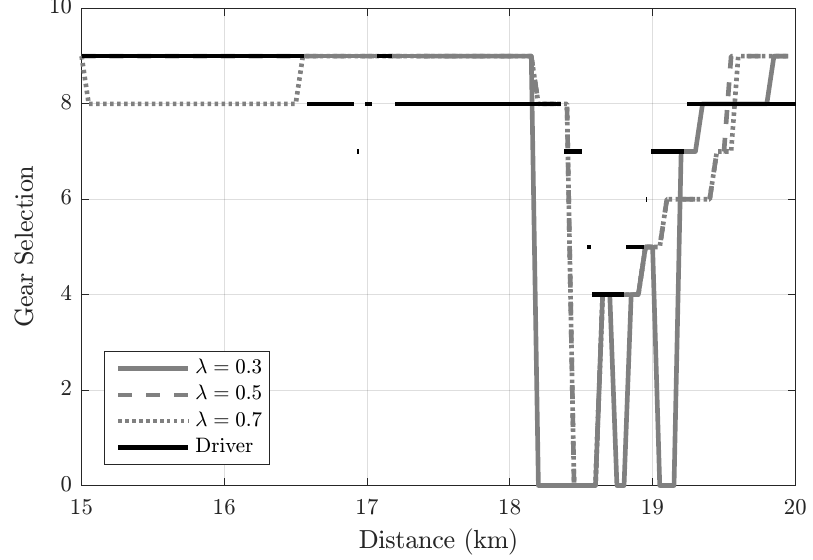
Figure 10. Gear profiles of the optimization algorithm and driver selection where zero corresponds to neutral, and the discontinuity in the driver gear selection is due to gear shift operations where no gear is